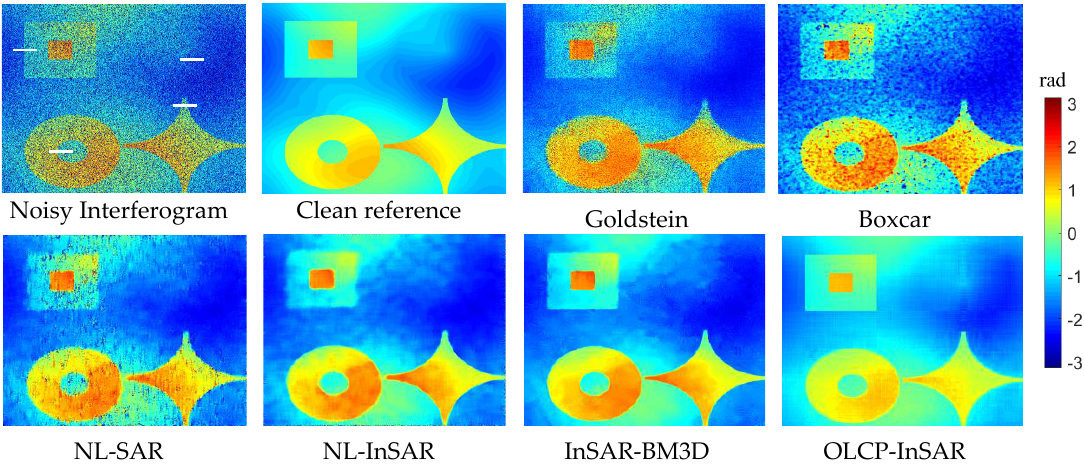
Table 4. The number of residues remaining in a filtered interferogram with different noise conditions.